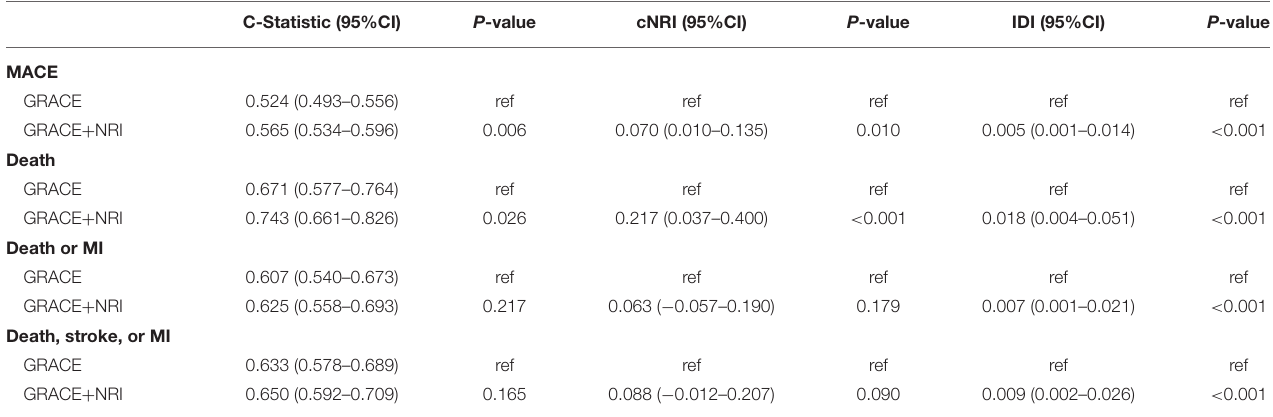
TABLE 4 | Model performance after the addition of NRI to the GRACE score in the overall